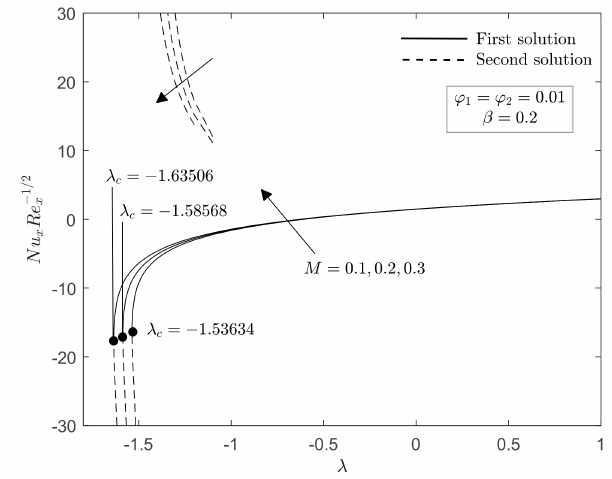
Figure 12. Local Nusselt number Nu x Re − 1/2 x with λ for selected values of magnetic parameter M when β = 0.2.